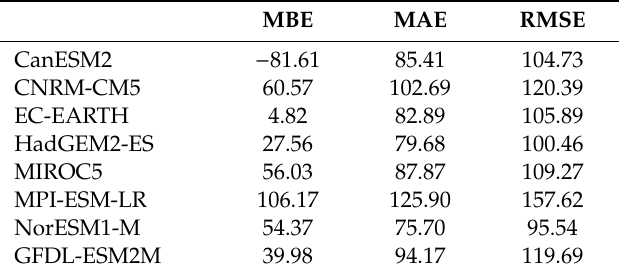
Figure 9. Fourth quarter total rainfall evolution. Table 12. Results of statistical criteria for fourth quarter total precipitation.